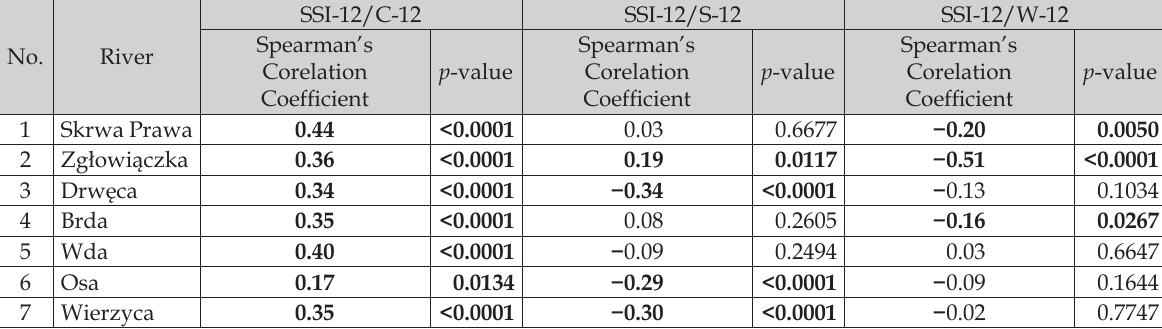
Fig. 6. The course of monthly indices of atmospheric circulation (C-12, S-12, W-12) and SSI-12 exemplified by the Brda River in 1954–2018. SSI, Standardised Streamflow Index. Table 5. Relationship between dry periods in the analysed rivers and atmospheric circulation indices in